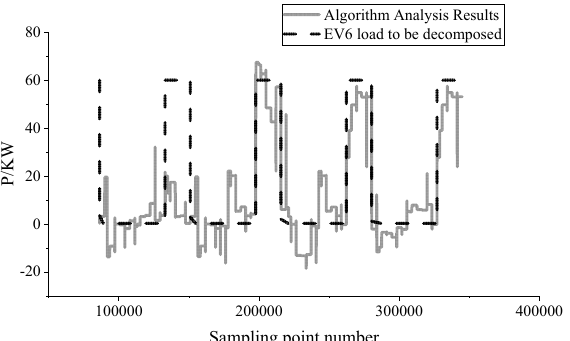
Figure 10. Decomposition results of deep neural network on EV6 of new load electric vehicle charg ‐ ing station.